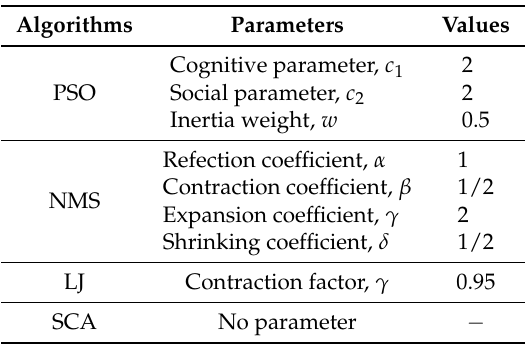
Table 3. Algorithm-specific parameters for different algorithms.